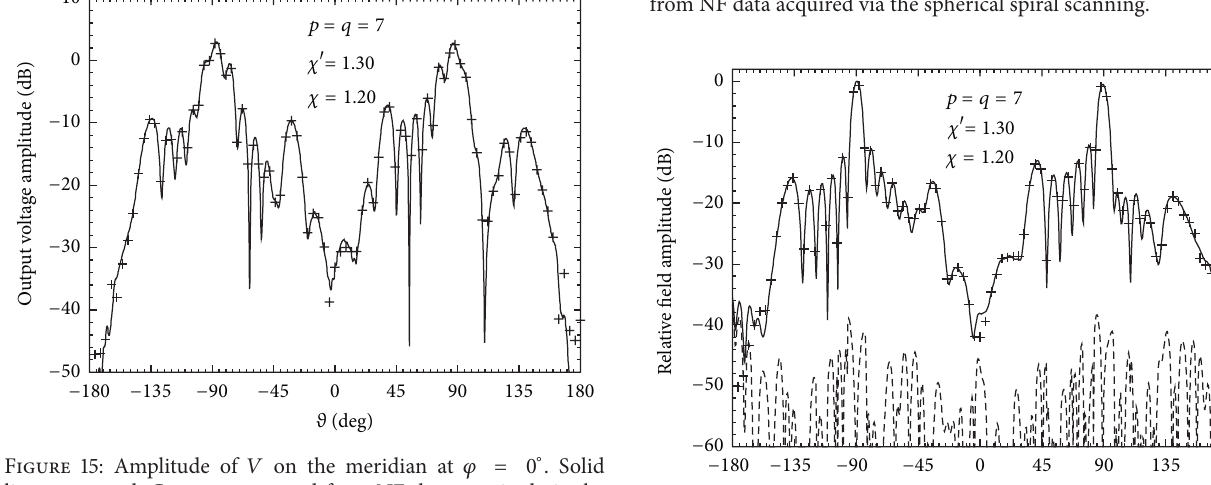
Figure 17: E-plane pattern. Solid line: reference. Crosses: recovered from NF data acquired via the spherical spiral scanning.